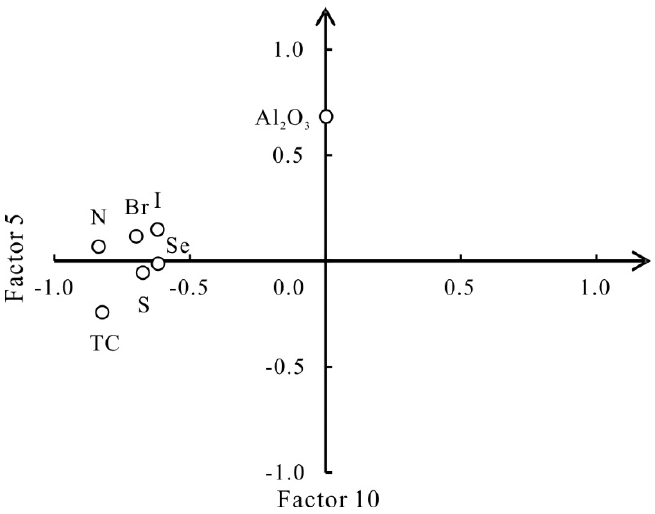
Figure 13. Biplot of F5 (TC − N − S − Br − I − Se association) vs. F10 (Al 2 O 3 ). Circles indicate elements.